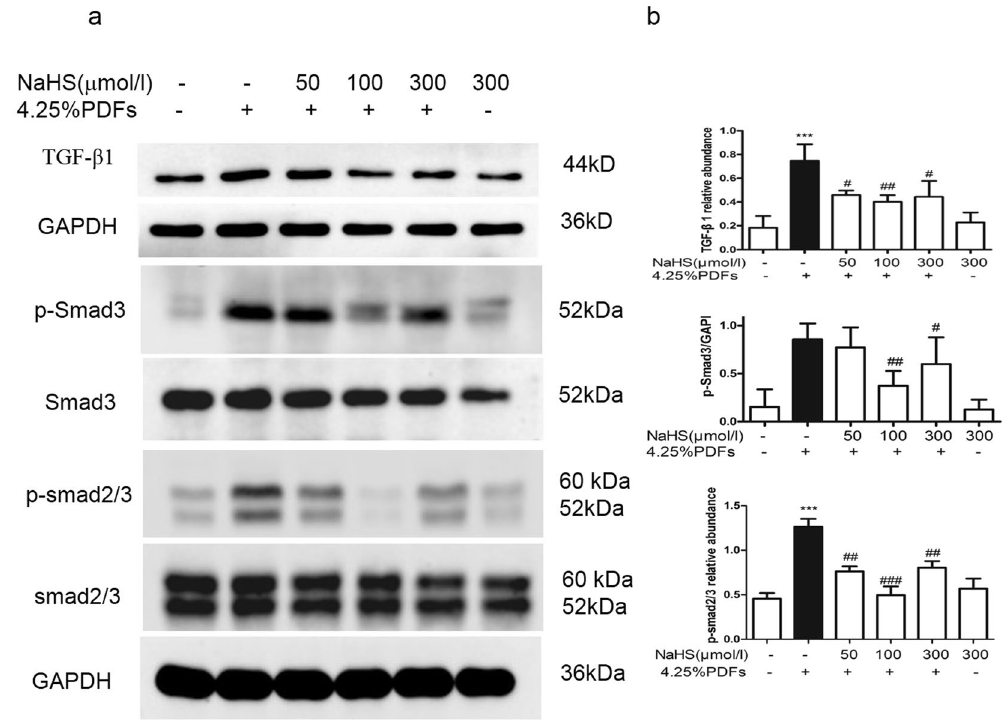
Figure 6. Effect of H 2 S on TGF- β 1 signal pathway activated by 4.25% glucose PDFs in RPMCs. RPMCs were incubated with or without NaHS (50, 100, 300 μ mol/L) for 30 min, followed by the stimulation of the mixture of 4.25% glucose PDFs and culture medium by 1:1 for 1 h. ( a ) Representative images of TGF- β 1, phospho-Smad3, phospho-Smad2/3 are presented and ( b ) relative abundance of these proteins in each group are calculated. Data represent mean ± SD of three independent experiments. ** P < 0.01 versus control group; # P < 0.05, ## P < 0.01 versus 4.25% glucose PDFs